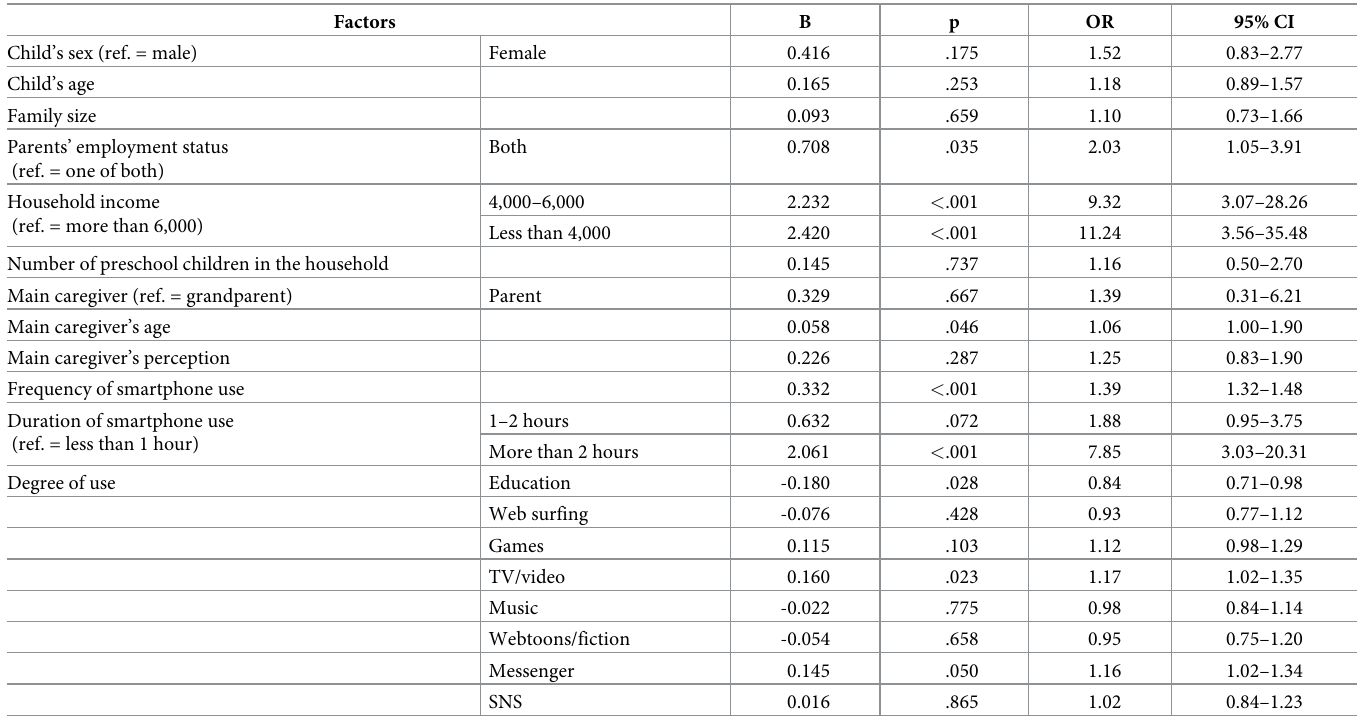
Table 3. Potential PSU risk